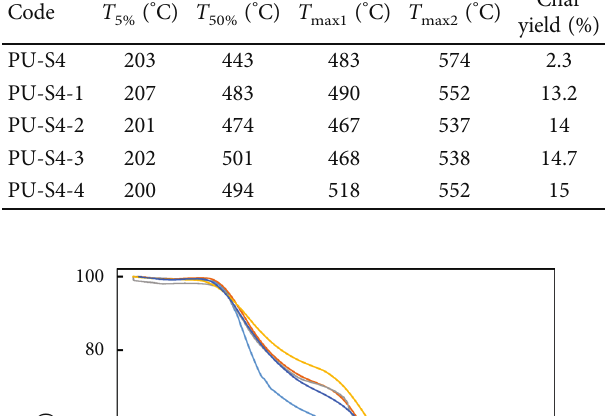
Table 5: Summary of TGA results for PURF nanocomposites. Code